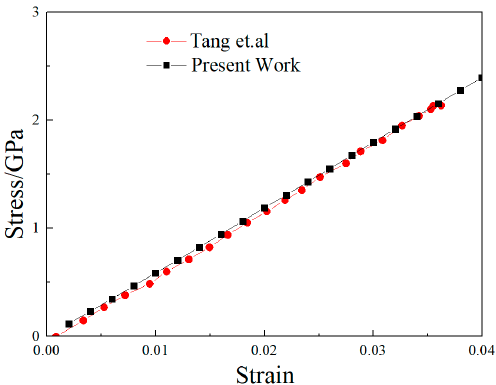
Figure 2. Stress vs. strain relationship of single-crystal pure magnesium stretched along the Z -axis.